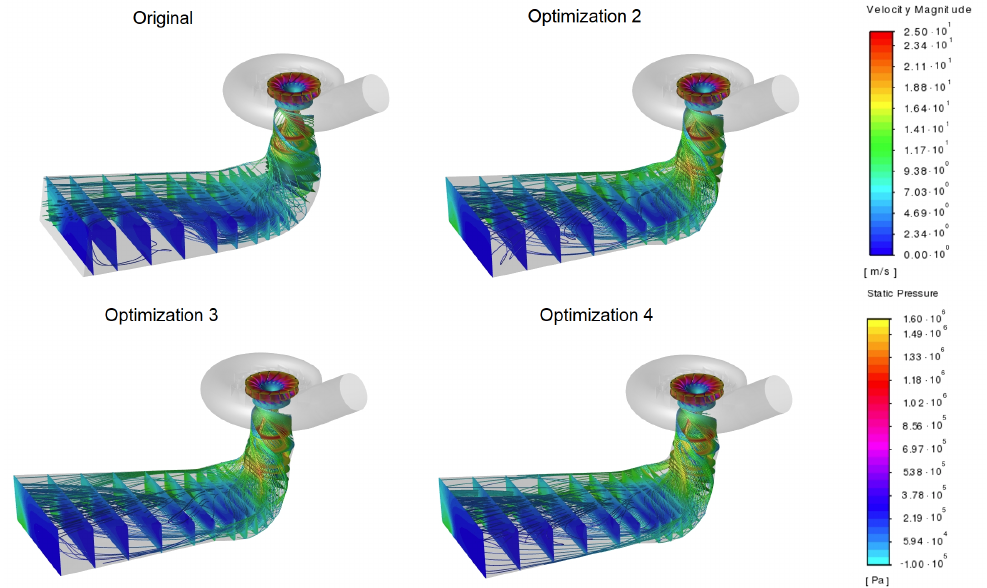
Figure 7. Runner colored to show static pressure value and the contours of the velocity magnitudes in several draft tube cross-sections, with pathlines starting from the runner outlet for an inlet volume flow rate of 14.3 m 3